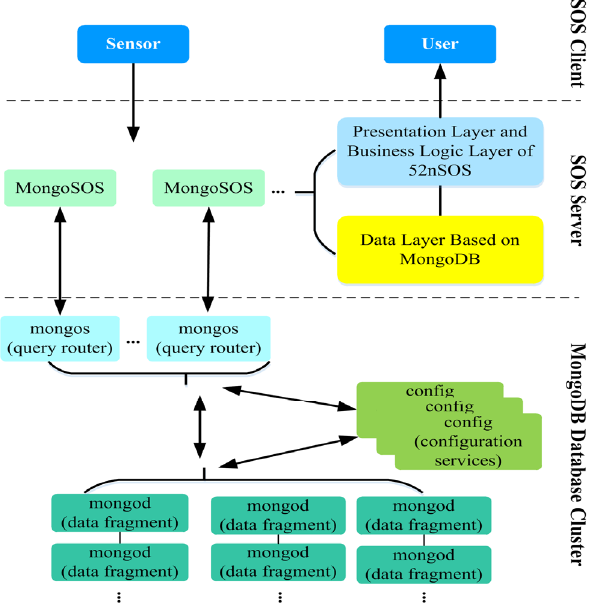
Figure 6. Architecture of MongoSOS to elevate performance on Sensor Observation Service.